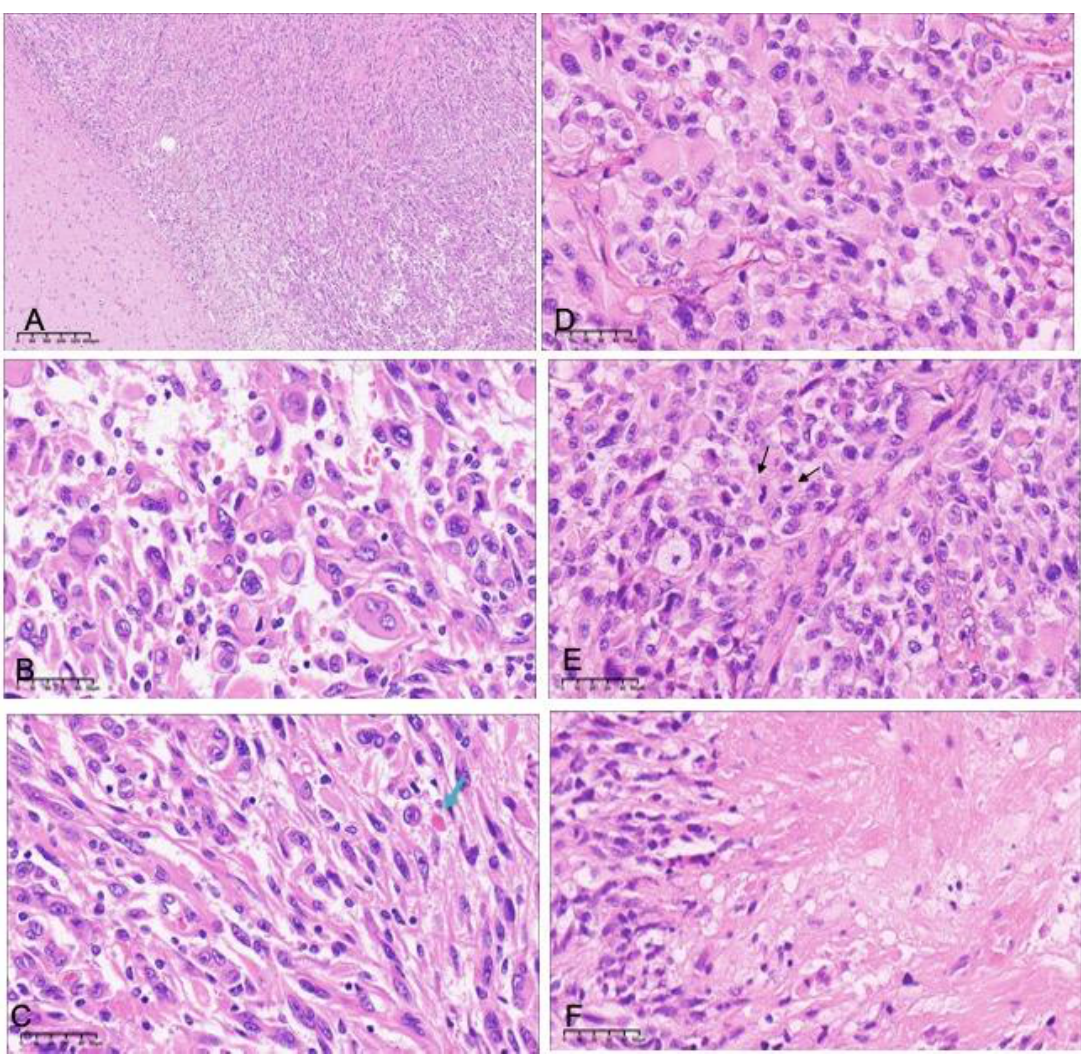
Figure 1. Histopathologic features of grade 2 ( A – C ) and grade 3 ( D – F ) pleomorphic xanthoastrocytoma. ( A ) There is a clear boundary between the tumor and the brain tissue in grade 2 PXA (H&E ×40). There is an admixture of spindle cells and neoplastic cells with bizarre nuclei or multinucleation ( B ) and eosinophilic granular bodies ( C , arrows) (H&E ×400). Grade 3 pleomorphic xanthoastrocytoma showing ( D ) a more pronounced epithelioid component, ( E ) high levels of mitotic activity (arrows), and ( F ) focal necrosis (H&E ×400).